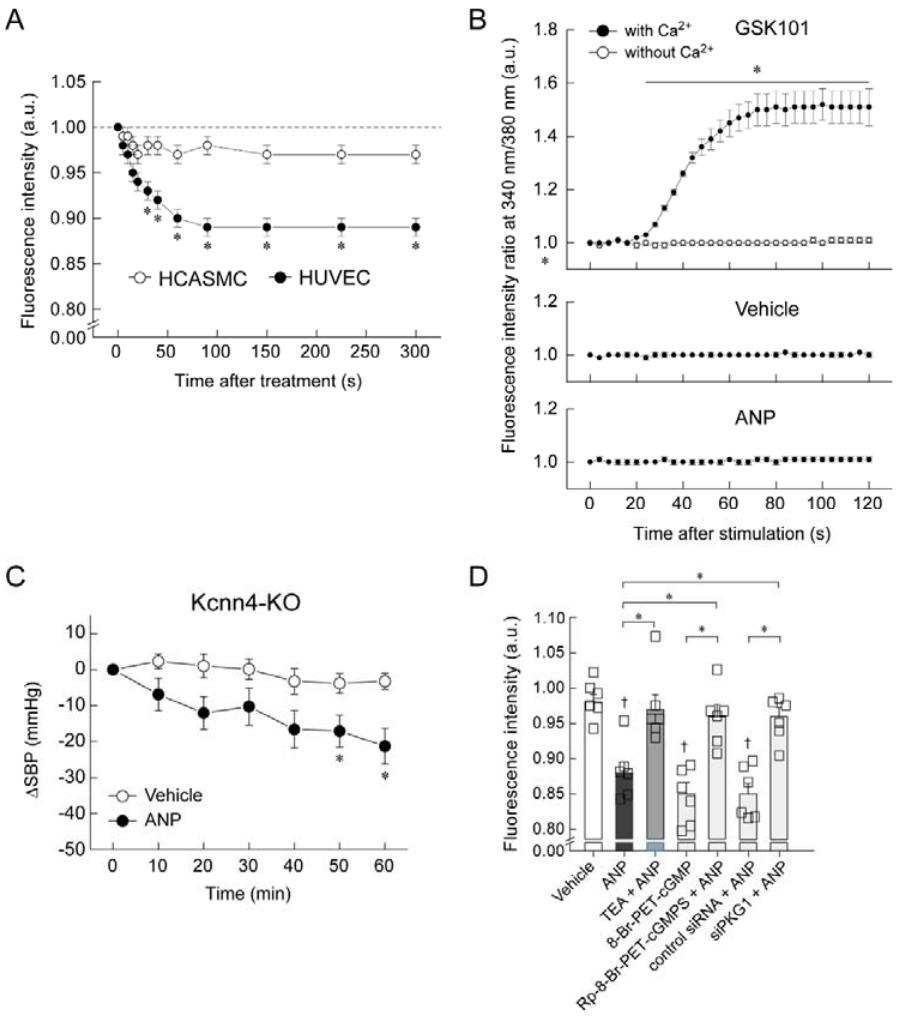
Figure 5. ANP causes hyperpolarization of cultured vascular endothelial cells in a K + channel ‐ de ‐ pendent manner via the GC ‐ A–PKG1 signaling pathway. ( A ) ANP significantly decreased the mem ‐ brane potential of human umbilical vein endothelial cells (HUVECs) compared with that in the hu ‐ man coronary artery smooth muscle cells (HCASMCs). Changes in the membrane potential were evaluated by monitoring the cellular fluorescence intensity. Values are expressed relative to the in ‐ tensity at time 0. * p < 0.05 vs. HCASMCs. ( B ) ANP had no effect on the intracellular calcium con ‐ centration of HUVECs. Fura ‐ 2 ‐ AM ‐ loaded HUVECs were stimulated with or without ANP, and cellular fluorescence was monitored for 120 s. GSK101 (TRPV4 agonist) was used as the positive control. * p < 0.05 vs. without Ca 2+ . ( C ) Intravenous infusion of ANP (10 μ g/kg/min) significantly lowered systolic blood pressure (SBP) compared with vehicle (saline) administration in